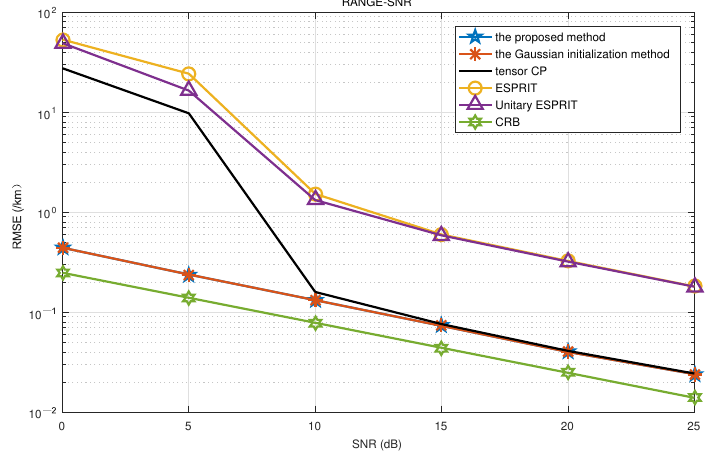
Figure 8. RMSE of range estimation versus SNR with closed